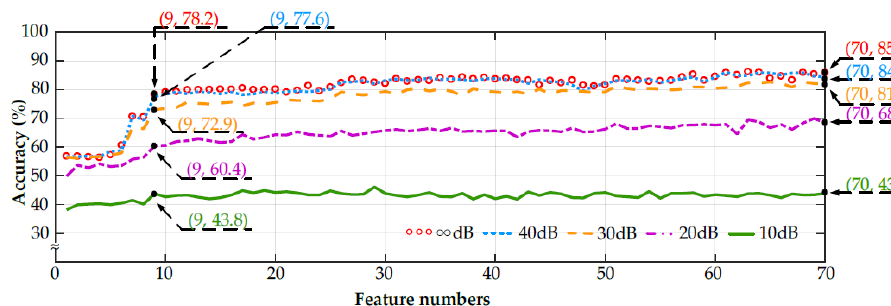
Figure 10. Accuracy curves of the MRA–ReliefF.